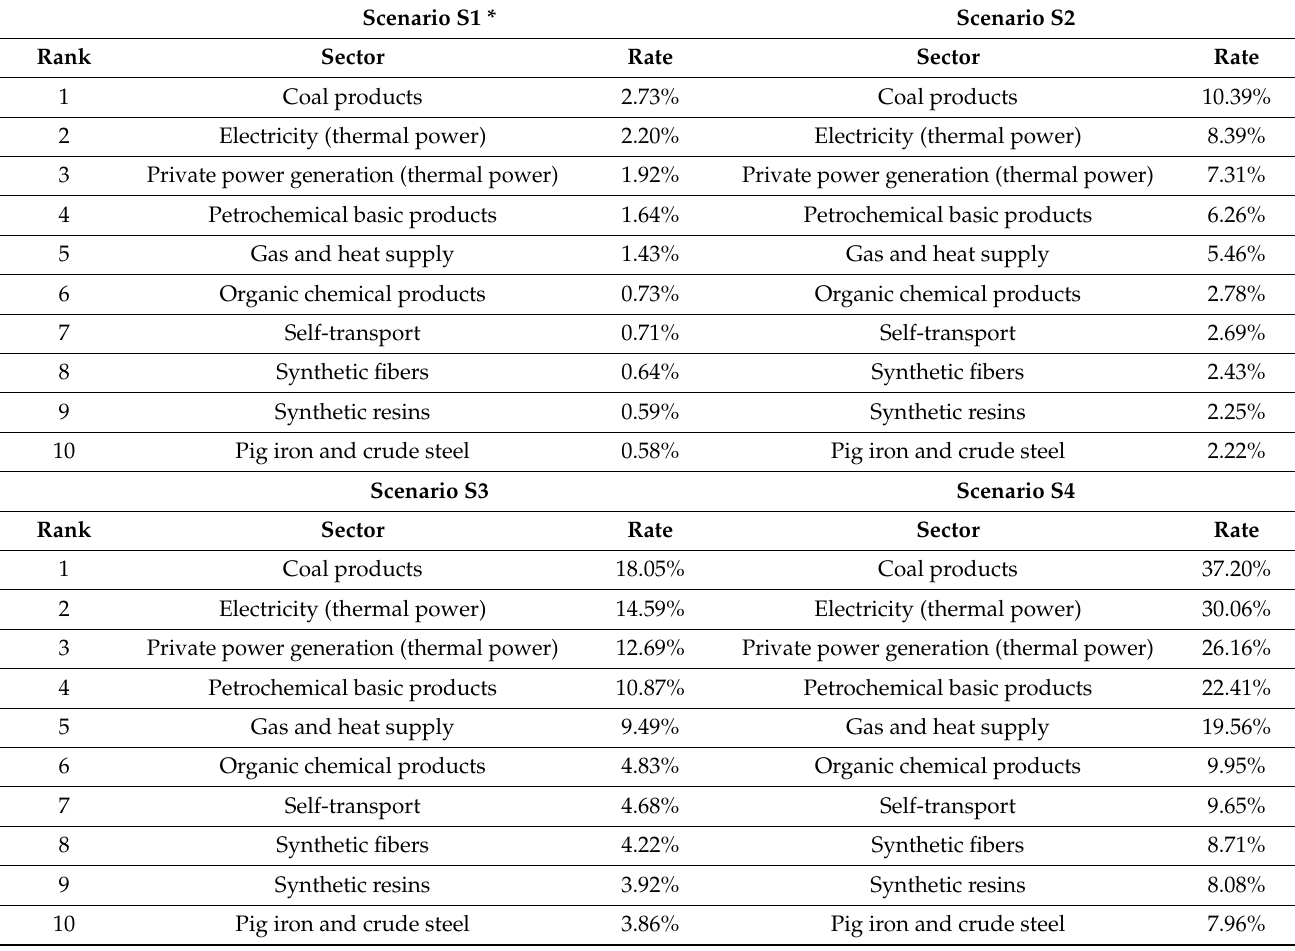
Table 4. Price increase due to the TGWC increase (top 10